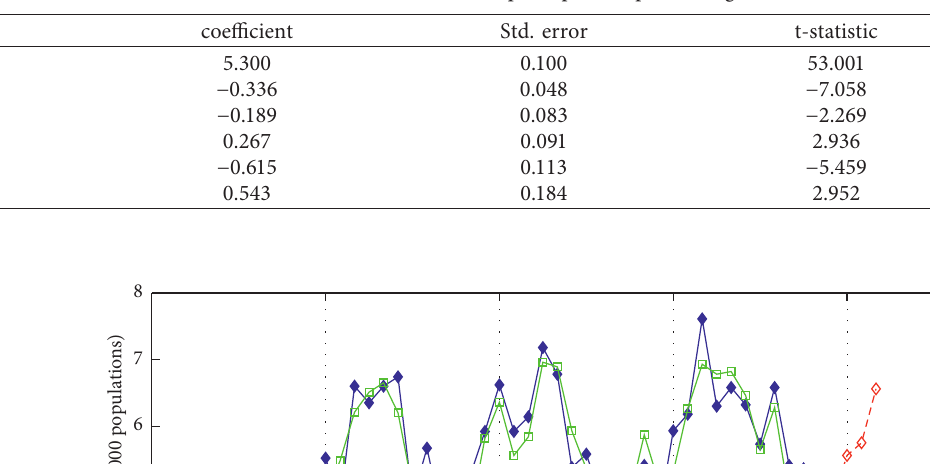
Table 8: The test results of principal component regression.